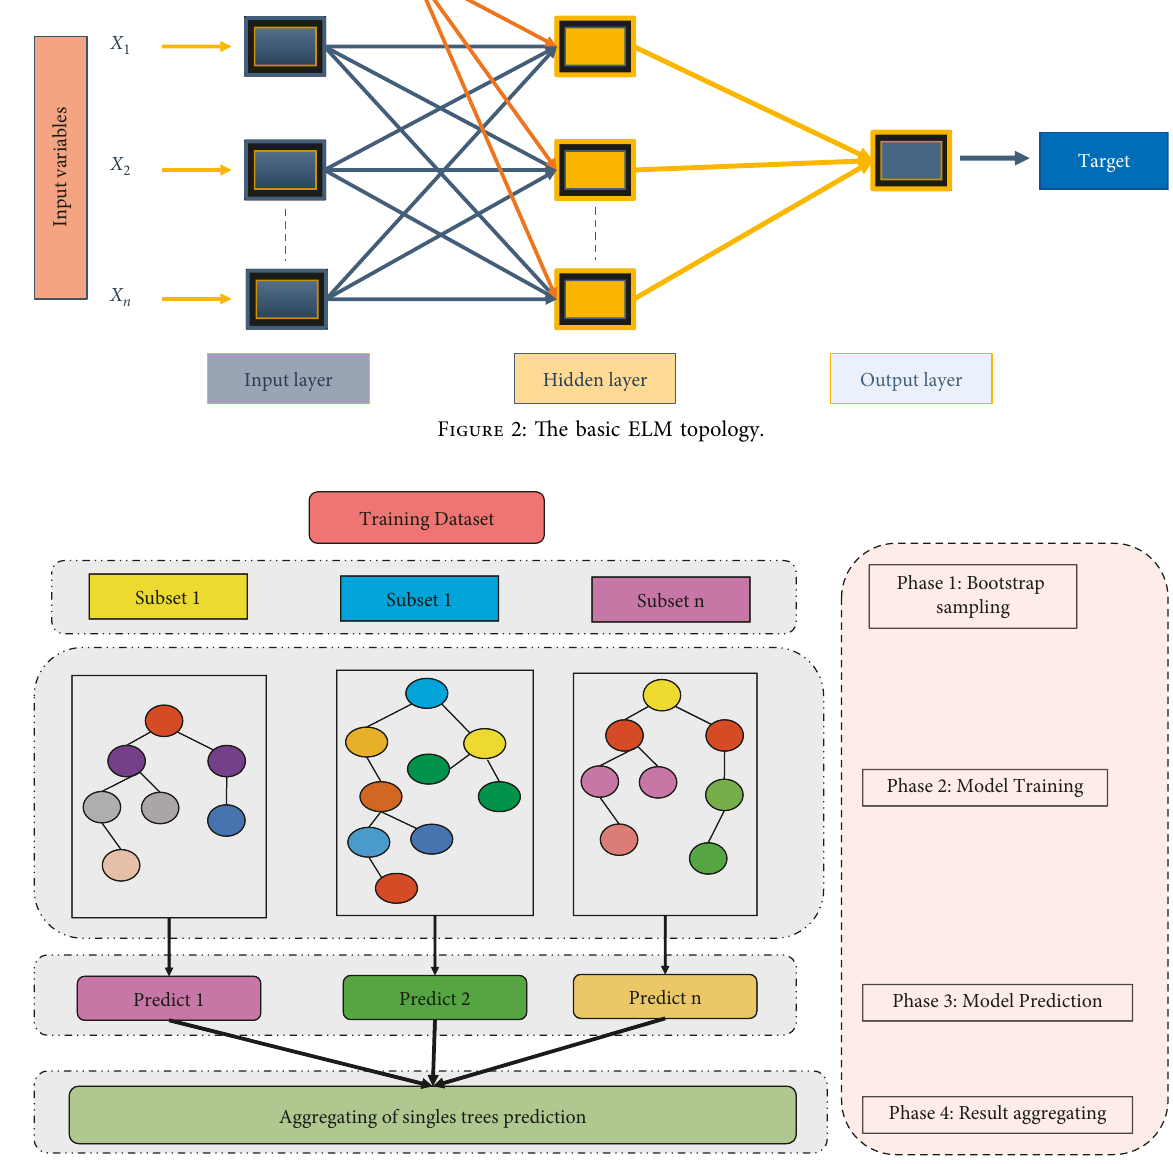
Figure 3: The basic structure of random forest